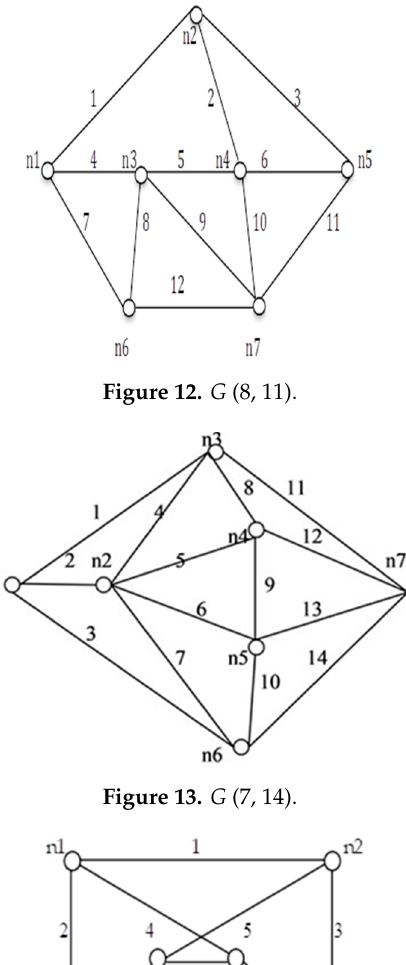
Figure 14. G (6, 8).